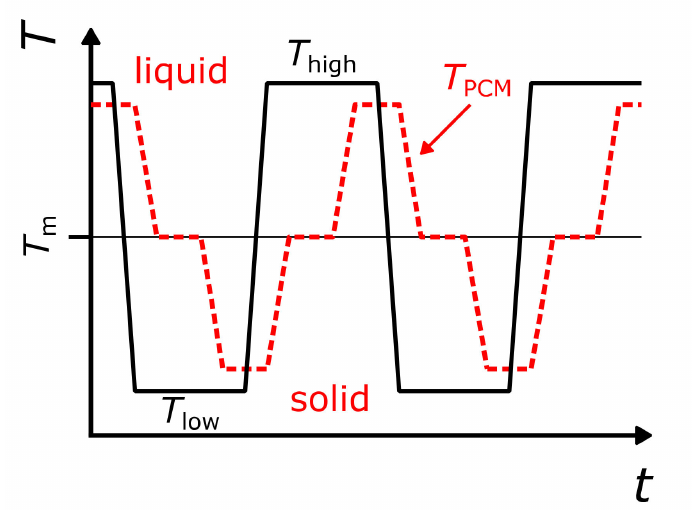
Figure 1. Idealized temperature–time curves of a thermal cycling stability experiment of a solid–liquid phase change material (PCM); PCM temperature (red dashed line); and heat transfer medium temperature (black solid